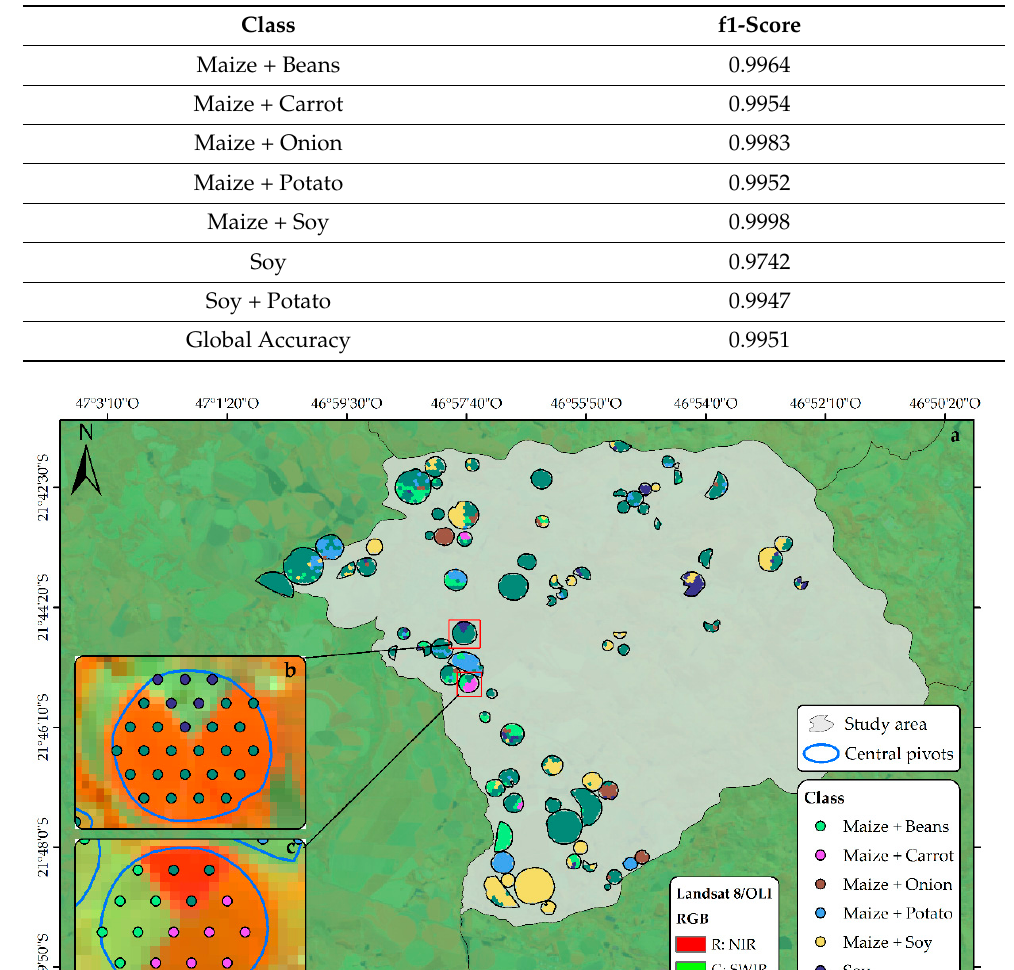
Figure 9. Crop area for each class in the 2015/2016 agricultural year. 4.3. Water Use 4.3.1. Summer Crop Season Figure 10 shows ETa values, rainfall, and the irrigation balance of the first cycle (soy and maize) for each meteorological data source used in the SSEBop-Br model. Regarding